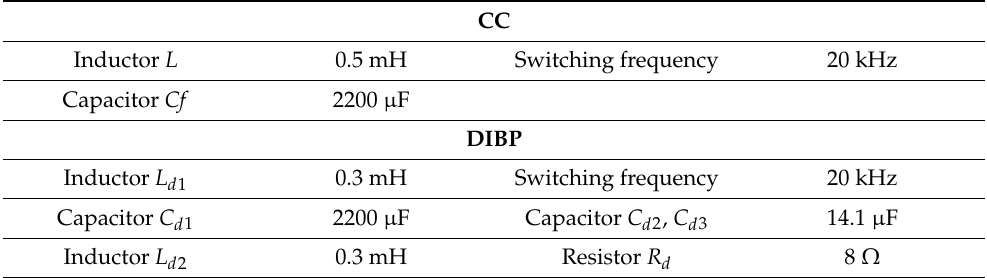
Table 1. Circuit parameters of prototype.